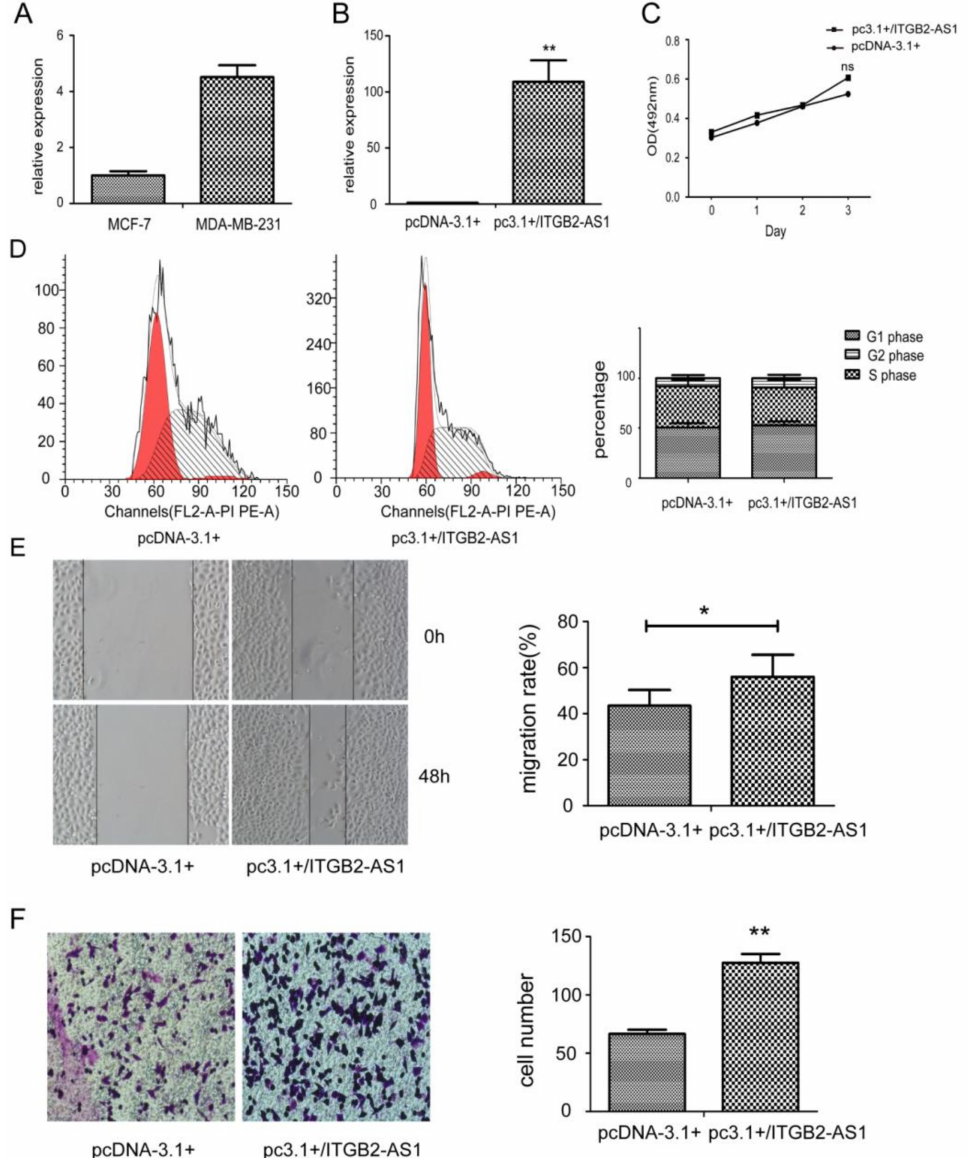
Figure 2. Overexpression of ITGB2-AS1 could promote the migration and invasion of MCF-7 cell. ( A ) The expression of ITGB2-AS1 in MDA-MB-231 and MCF-7 was measured by Q-PCR; ( B ) The validation of overexpression plasmid in MCF-7 by Q-PCR; ( C ) MTT assay; ( D ) The cell cycle was measured by flow cytometry. Left panel: X-axis: cell number; Y-axis: DNA content; ( E ) The migration was evaluated by wound healing assay; ( F ) The invasion was detected by transwell assay and stained by crystal violet (400 × ). Data are shown as mean ± SD. * p < 0.05, ** p < 0.01 vs. control